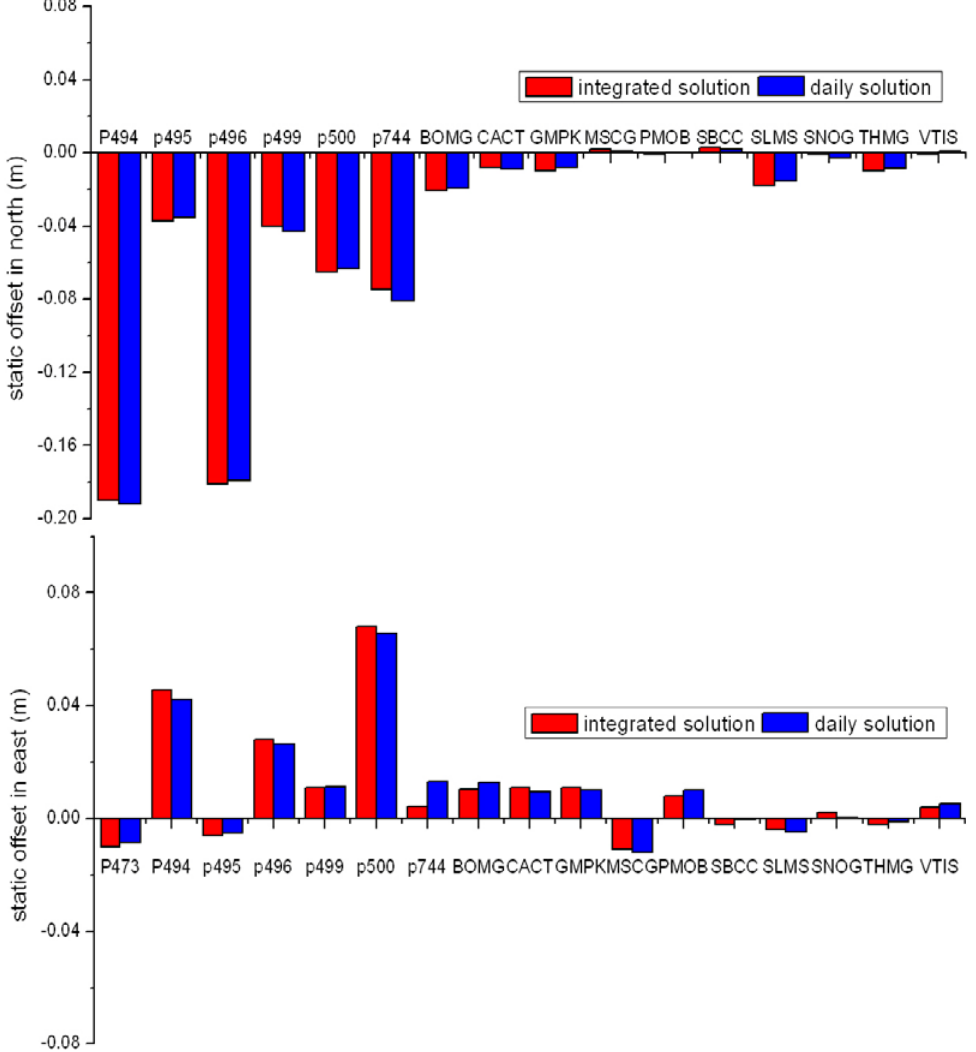
Figure 7. Comparison of the permanent (static) offsets from the tightly-integrated solution and the post-processed daily solution. The blue rectangle shows static offsets derived from the static PPP solution with daily observations (the difference between daily solutions of the day before the earthquake and the day after the earthquake). The red rectangles show the static offsets derived from the real-time tightly-integrated